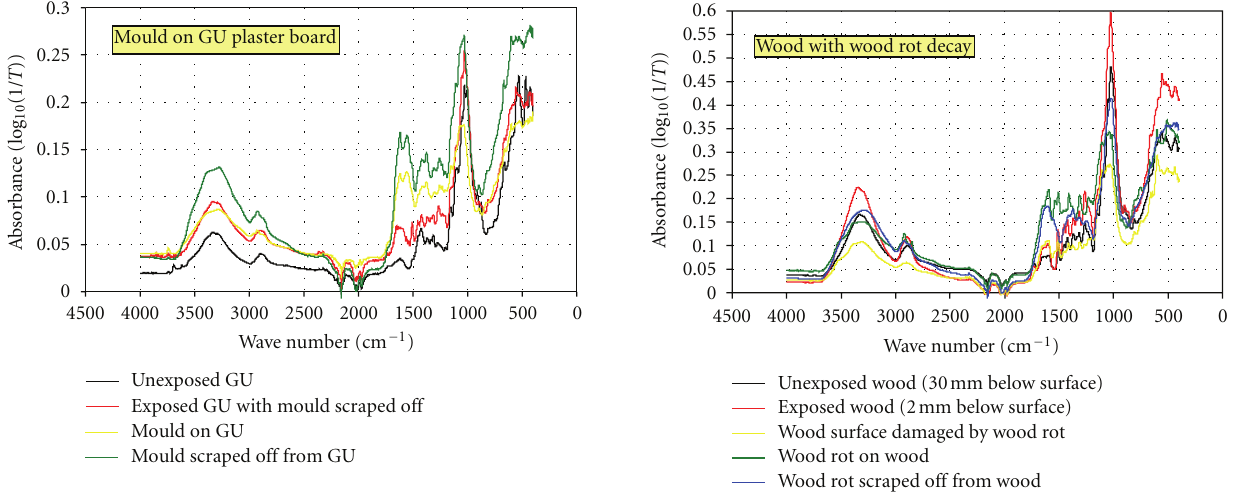
Figure 4: Absorbance (logarithmic) versus wave number between 4000–400 cm − 1 for wood rot at various exposure levels of wood rot decay.